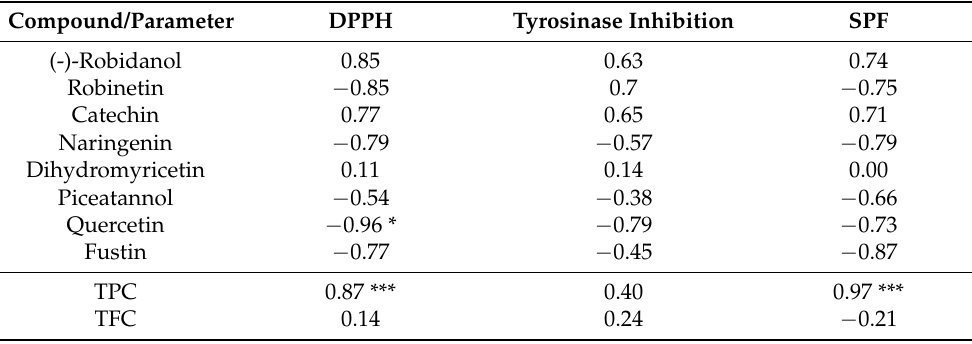
Table 5. Pearson’s correlation coefficient of identified compounds, TPC, and TFC to the bioactivity parameters of I. bijuga